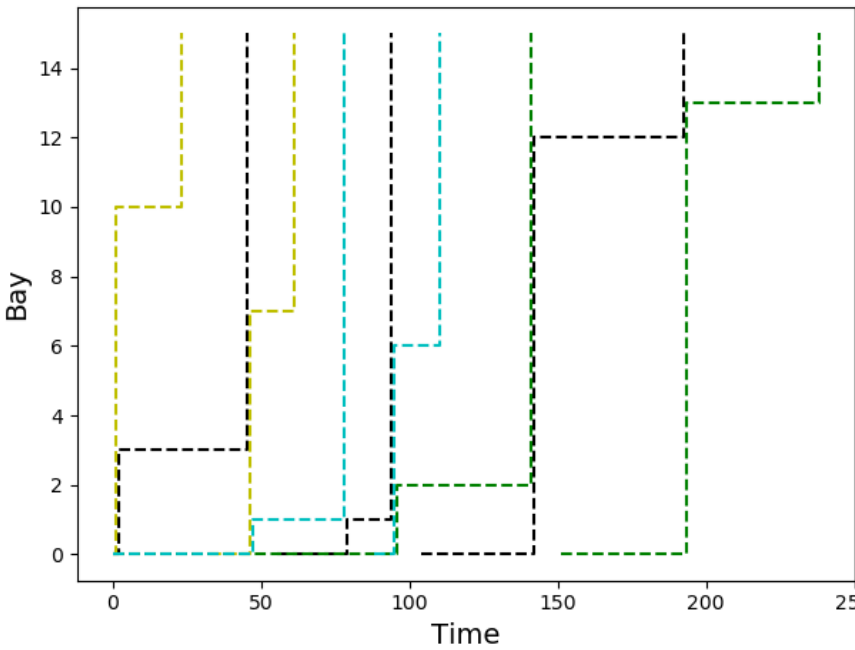
Figure A1. Numerical experiment: AGV time–space diagram.